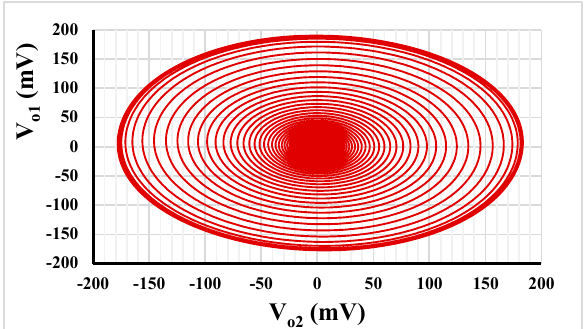
Figure 8. The quadrature relationship between V o 1 and V o 2 .